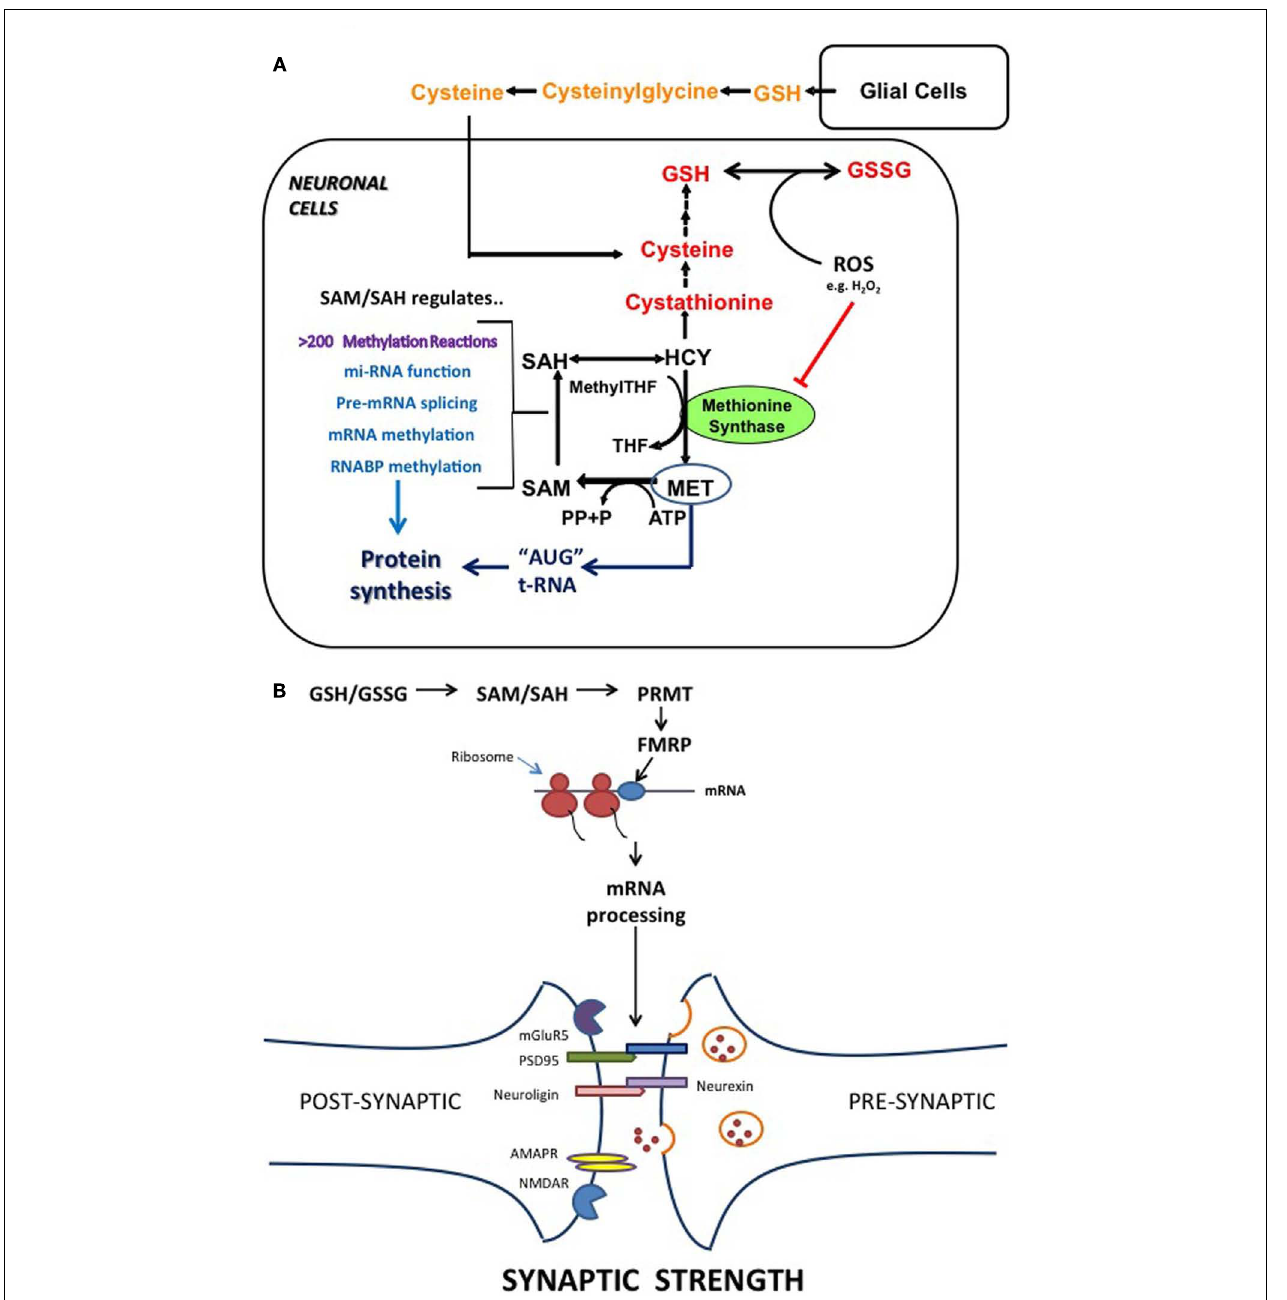
methylation. Levels of intracellular methionine affect protein synthesis, since it is the required amino acid for initiation of translation. (B) An example of a methyltransferase being regulated by redox status which affects neuronal plasticity. PRMT is a SAM-dependent methyltransferase which methylates the RGG domain of FMRP (a RNABP). FMRP is involved in regulation of about 400 different mRNA transcripts, including NLGN3 (neuroligin-3), PSD-95 (post synaptic density protein-95) and the AMPA-type glutamate receptor.Thus redox status, acting via methylation reactions, can control synaptic strength between neurons, thereby providing a potential molecular mechanism for Hebbian learning and memory